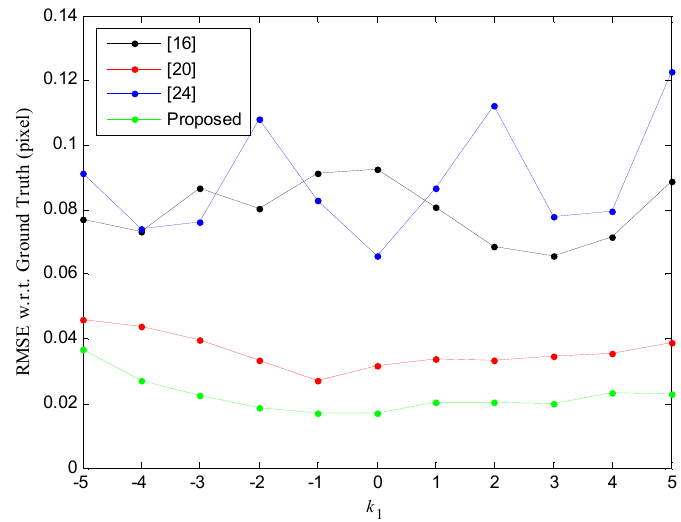
Figure 9. RMS error between localized and standard values as a function of k 1 for four different approaches.